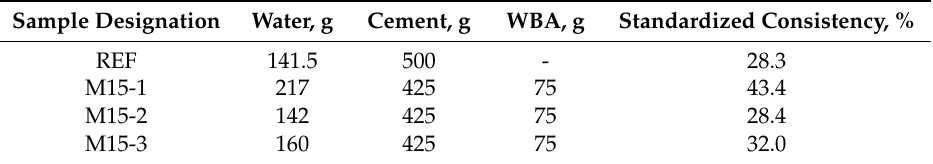
Table 4. Paste mix